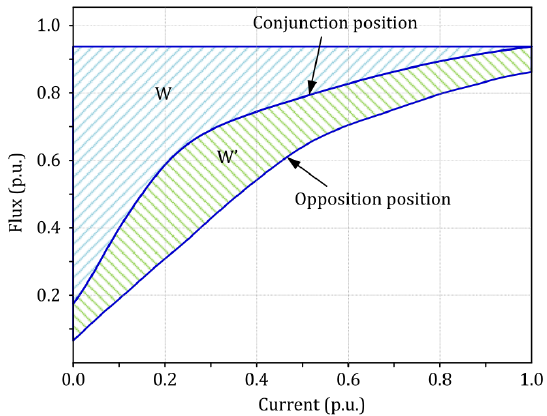
Figure 21. Operating cycle of the machine per phase over an electrical